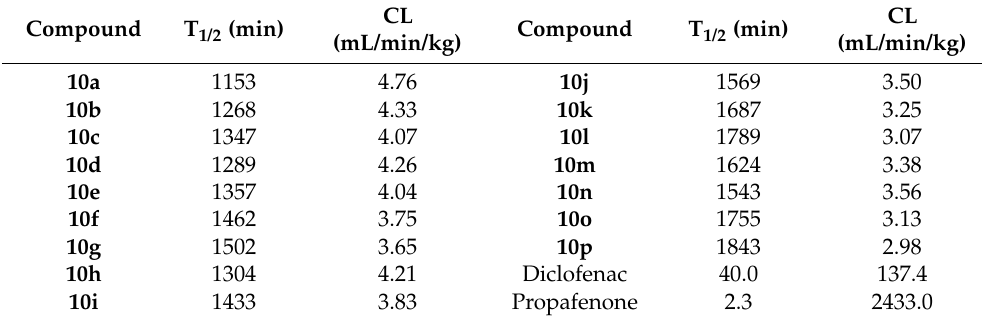
Table 6. Metabolic stabilities of compounds 10a – 10p in mouse liver microsomes.